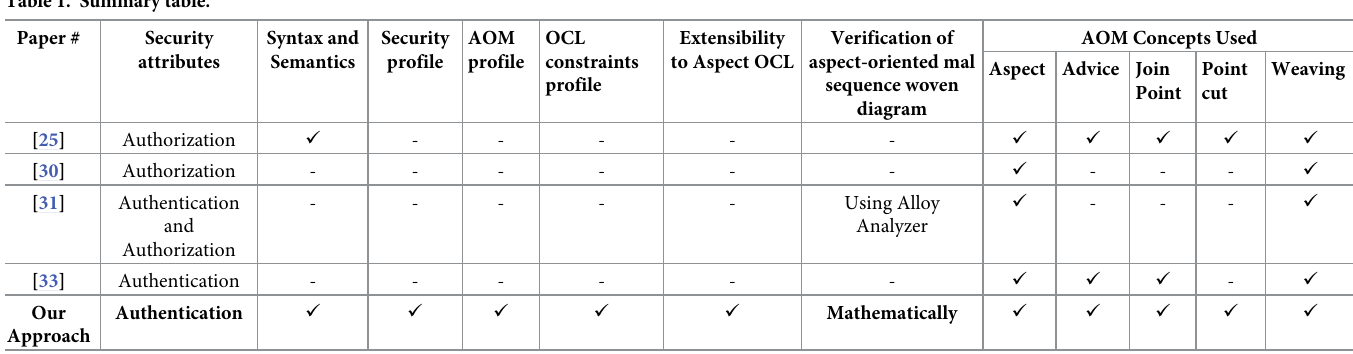
Table 1. Summary